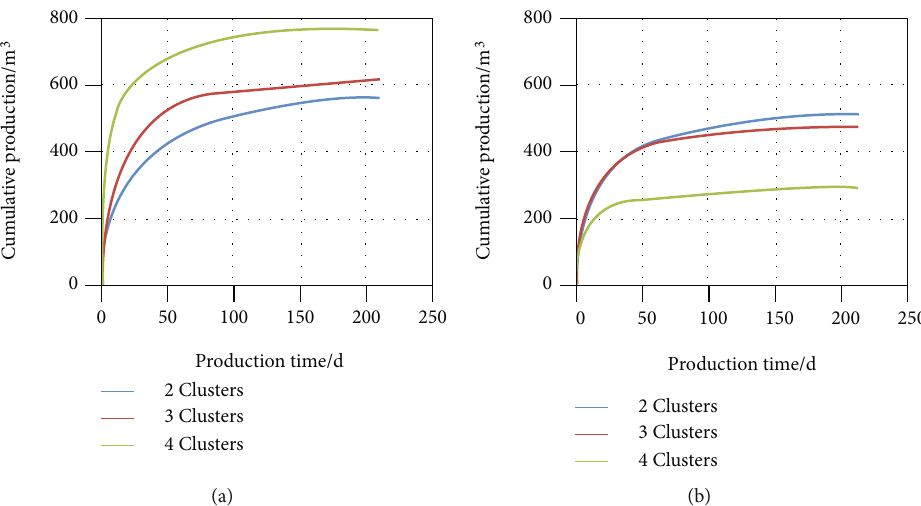
Figure 9: Comparison of cumulative production for di ff erent clusters of the same section length: (a) cumulative oil production and (b) cumulative water production.